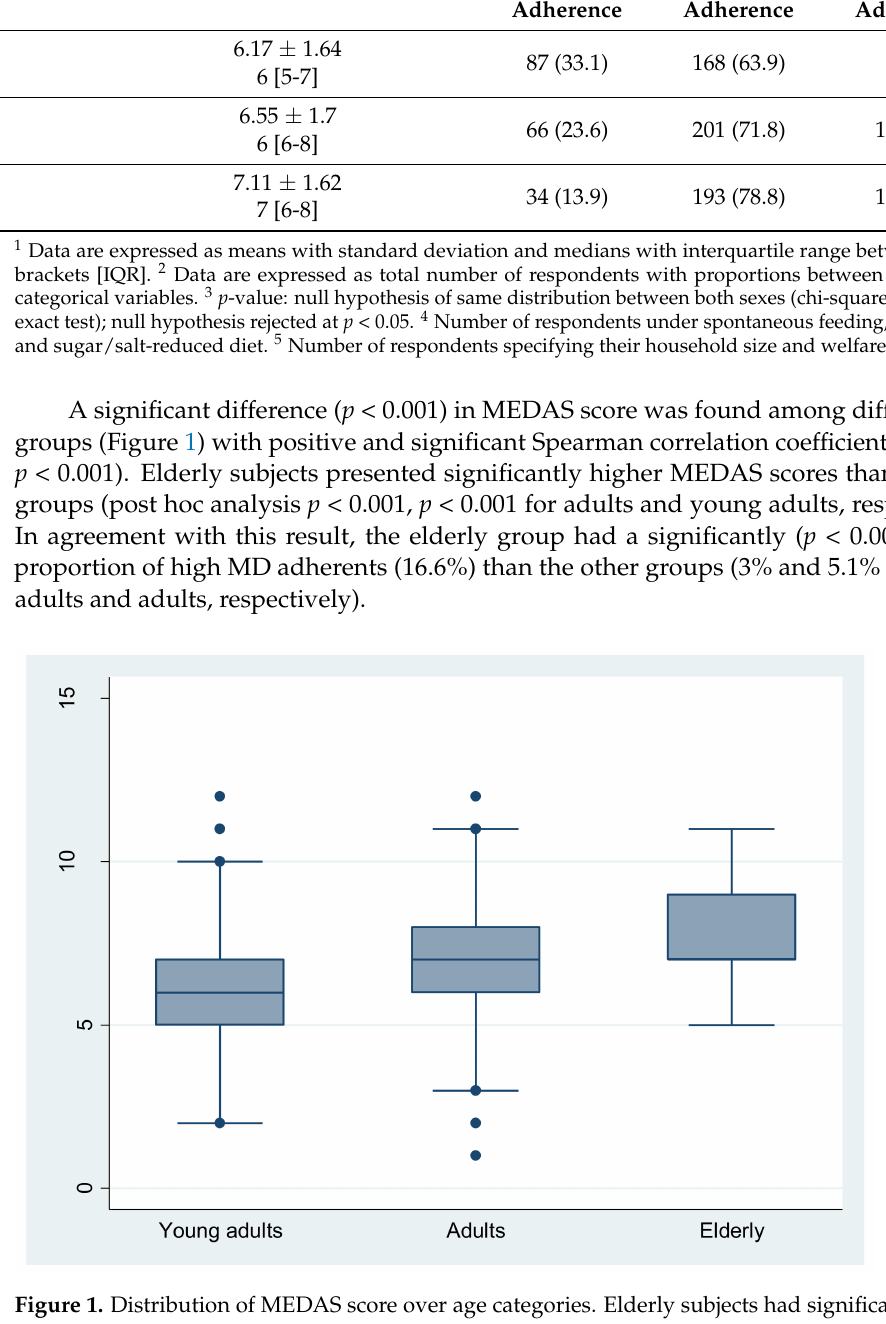
Figure 1. Distribution of MEDAS score over age categories. Elderly subjects had significantly higher MEDAS scores than younger groups (post hoc analysis p < 0.001, p < 0.001 for adults and young adults,